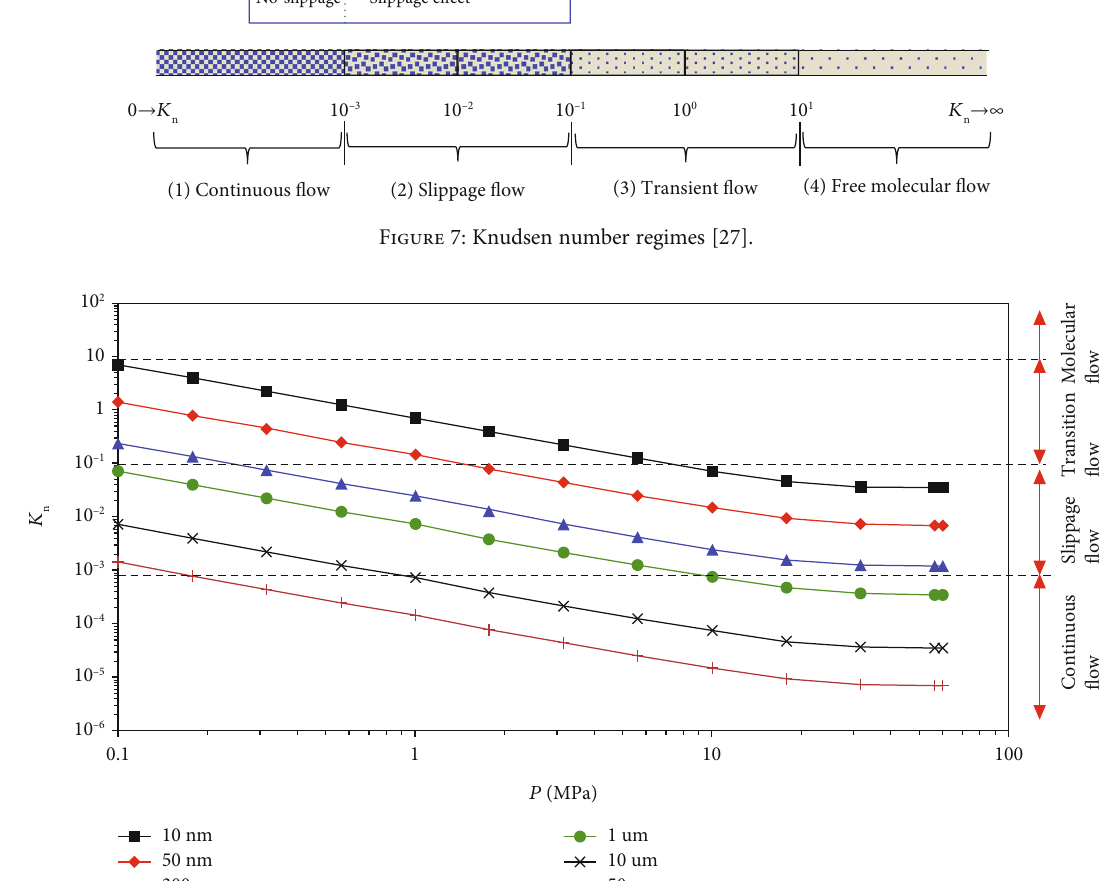
Figure 8: Flow regimes of methane under di ff erent pressure and pore